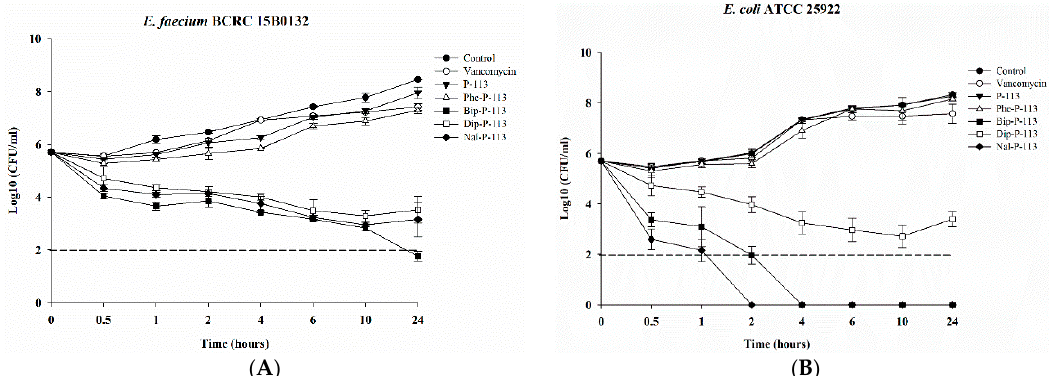
Figure 2. Killing kinetics of vancomycin, P-113 and its derivatives against VRE and E. coli strains. 5 × 10 5 CFU/mL of ( A ) E. faecium BCRC 15B0132, and ( B ) E. coli ATCC 25922 were treated with 1×MIC vancomycin, P-113, Phe-P-113, Bip-P-113, Dip-P-113, and Nal-P-113 for 0.5, 1, 2, 4, 6, 10, and 24 h at 37 °C. Bacteria without peptides and vancomycin were used as a control. Aliquots were removed at each time points, and 10-fold serial dilutions of the aliquot were plated onto Müller-Hinton agar. The numbers of CFU were counted after 24-hours incubation at 37 °C. The detection limit for the colony counts was 2log 10 CFU/mL. The experiments were performed in triplicate.